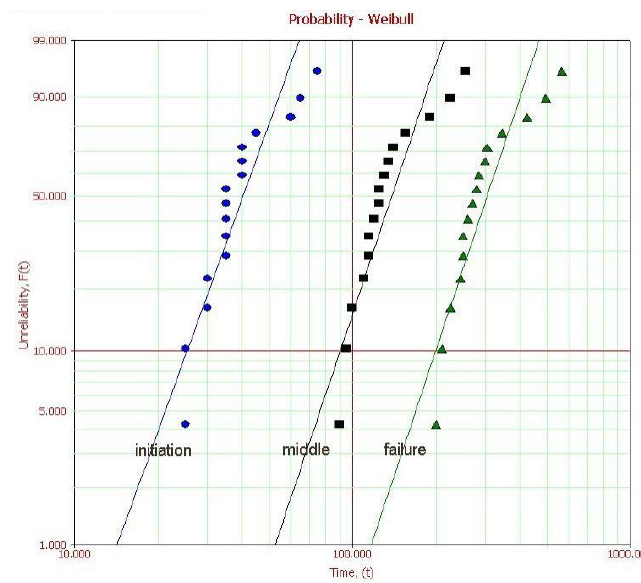
Figure 9. Time to failure of the Weibull distribution of tree model 1 (divided by three progress: initiation, middle, failure). Table 2. Shape and scale parameter of tree model